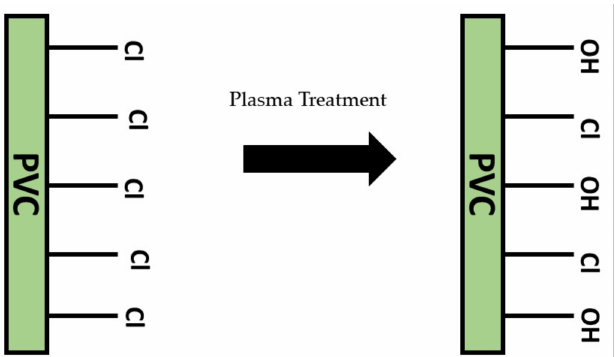
Figure 11. Plasma surface treatment changing surface morphology and functional group formation on the treated